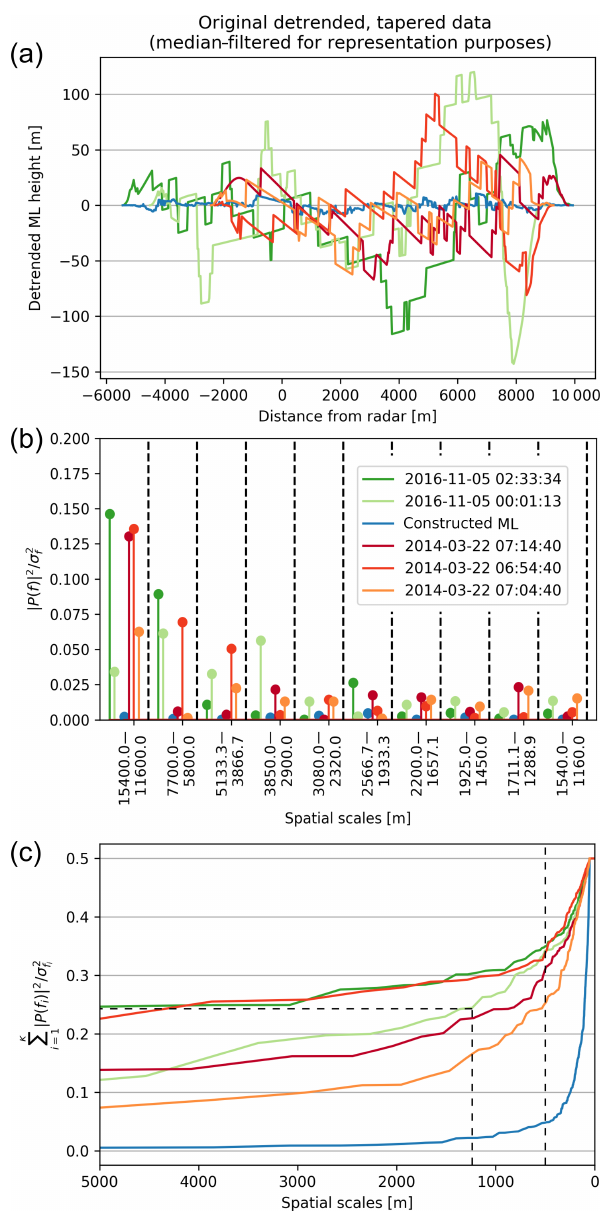
Figure 5. Examples of observed melting layer tops (a) , their cor- responding fractions of variance explained by components (b) and the cumulated fractions of variance explained (c) from the Valais campaign (green), from the Payerne campaign (red) and for a con- structed melting layer consisting of white noise with a drift